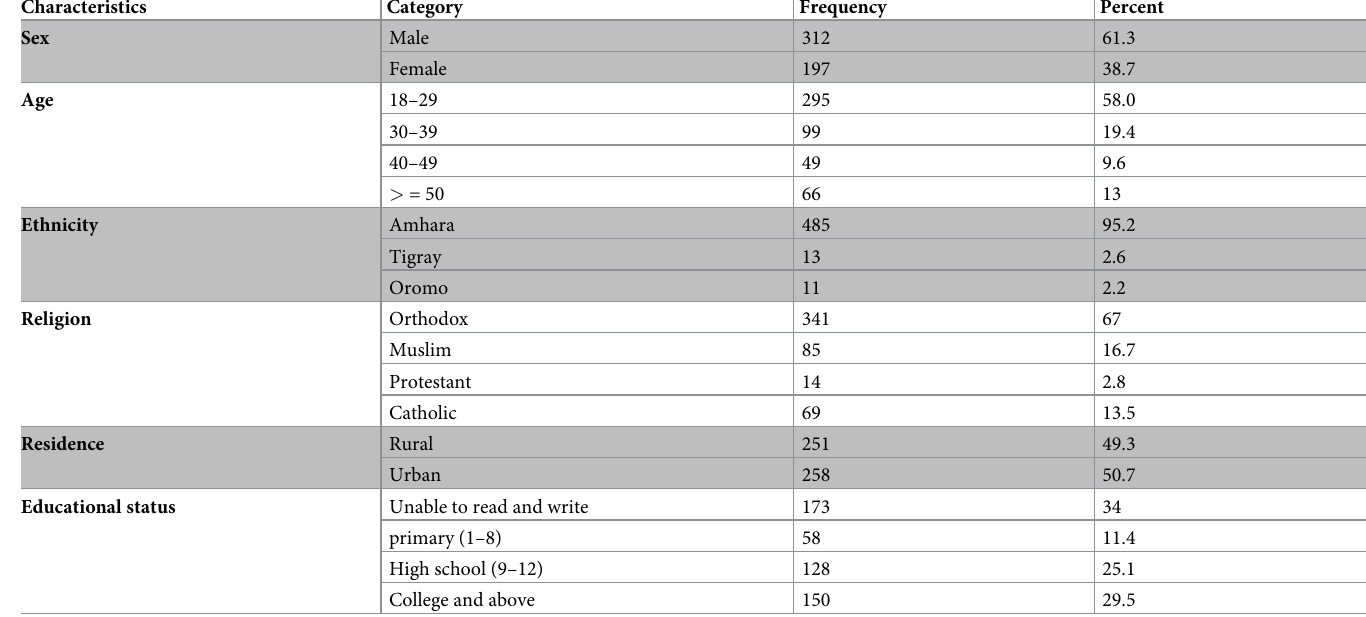
Table 1. Socio-demographic characteristics of patents with epilepsy attending outpatient department of South Gondar zone hospitals Amhara, Ethiopia, 2021 (n = 509).